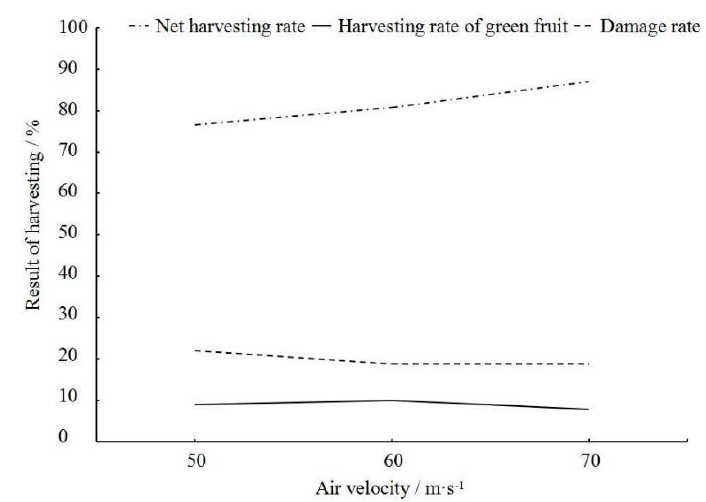
Figure 9. Effects of air velocity on different